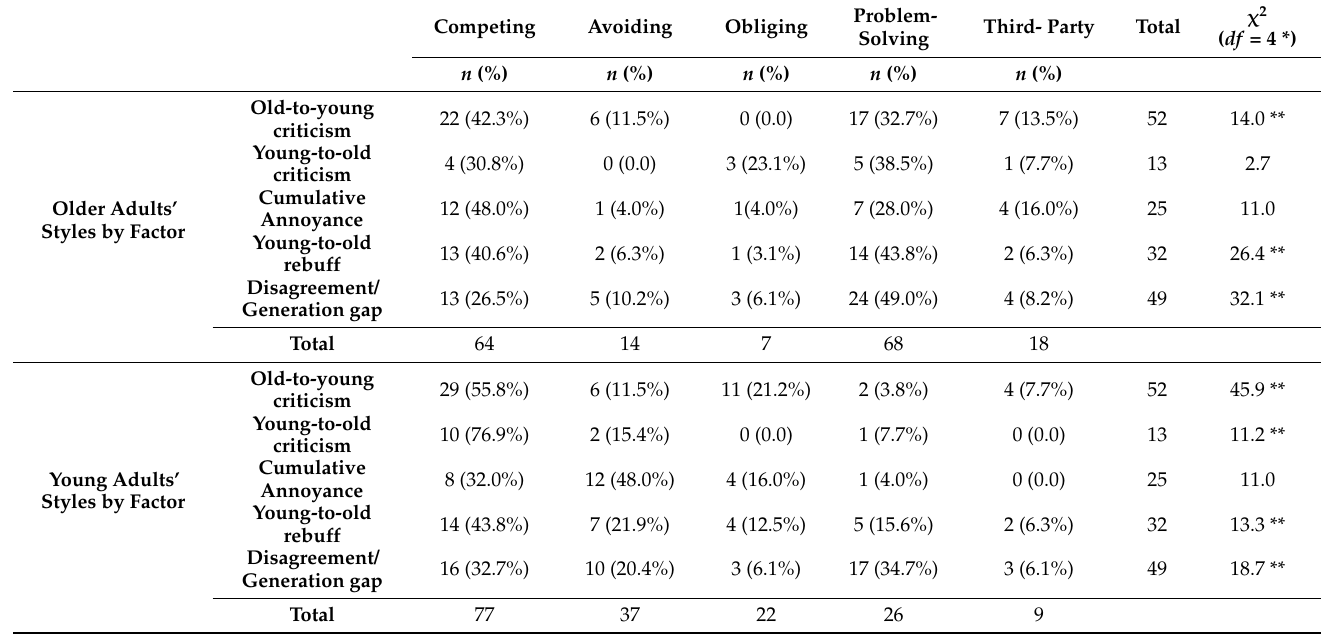
Table 6. Associations between conflict-initiating factors and young adults’ use of management styles in intergenerational